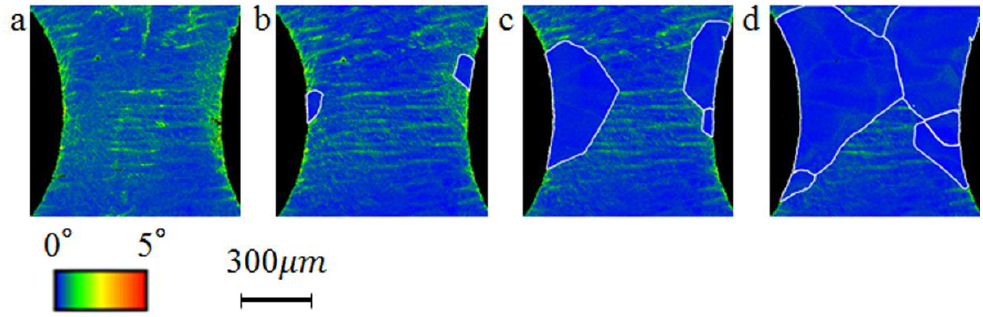
Figure 10. Microstructure evolution of specimen 1-2 at annealing time ( a ) 0 min; ( b ) 5 min; ( c ) 15 min; and ( d ) 60 min. Grain boundaries were highlighted with white lines.